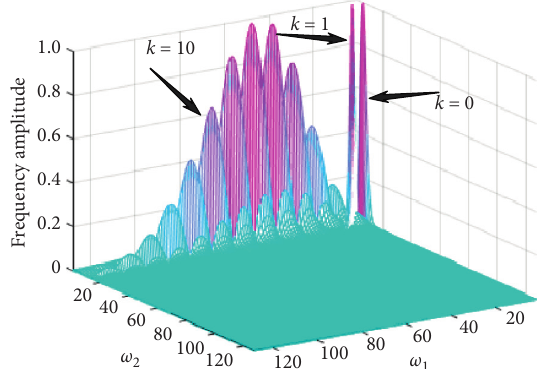
Figure 4: Spectral distribution in different directions.